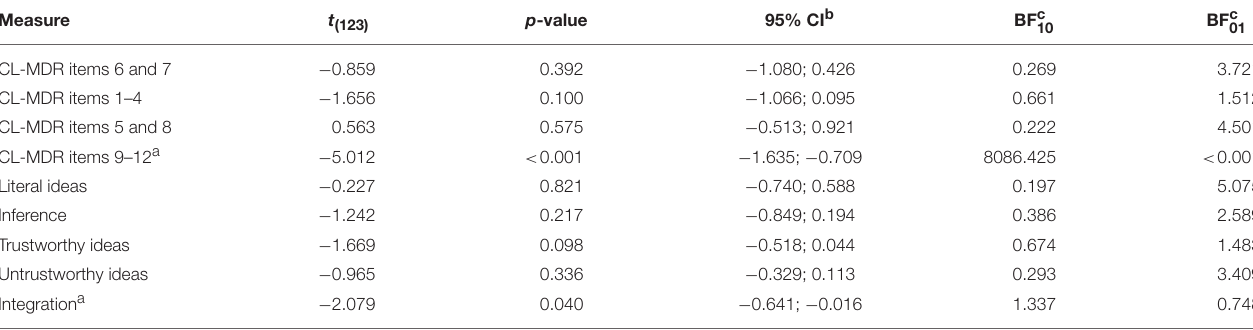
TABLE 4 | Outcomes of Frequentist and Bayesian t -tests for the differences between the two conditions in terms of cognitive load and essay performance: t -value (df = 123), p -value, 95% confidence interval (CI), and Bayes factors for the alternative hypothesis (i.e., there is a difference) vs. the null hypothesis (i.e., there is no difference) (BF 10 ) and for the null vs. the alternative hypothesis (BF 01